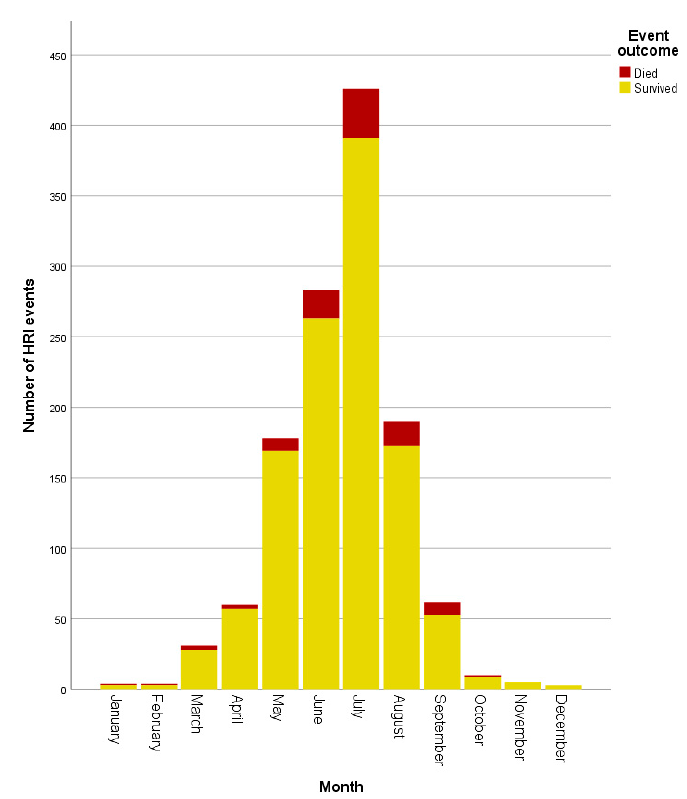
Figure 2. Histogram showing the number of heat-related illness events by outcome per month.